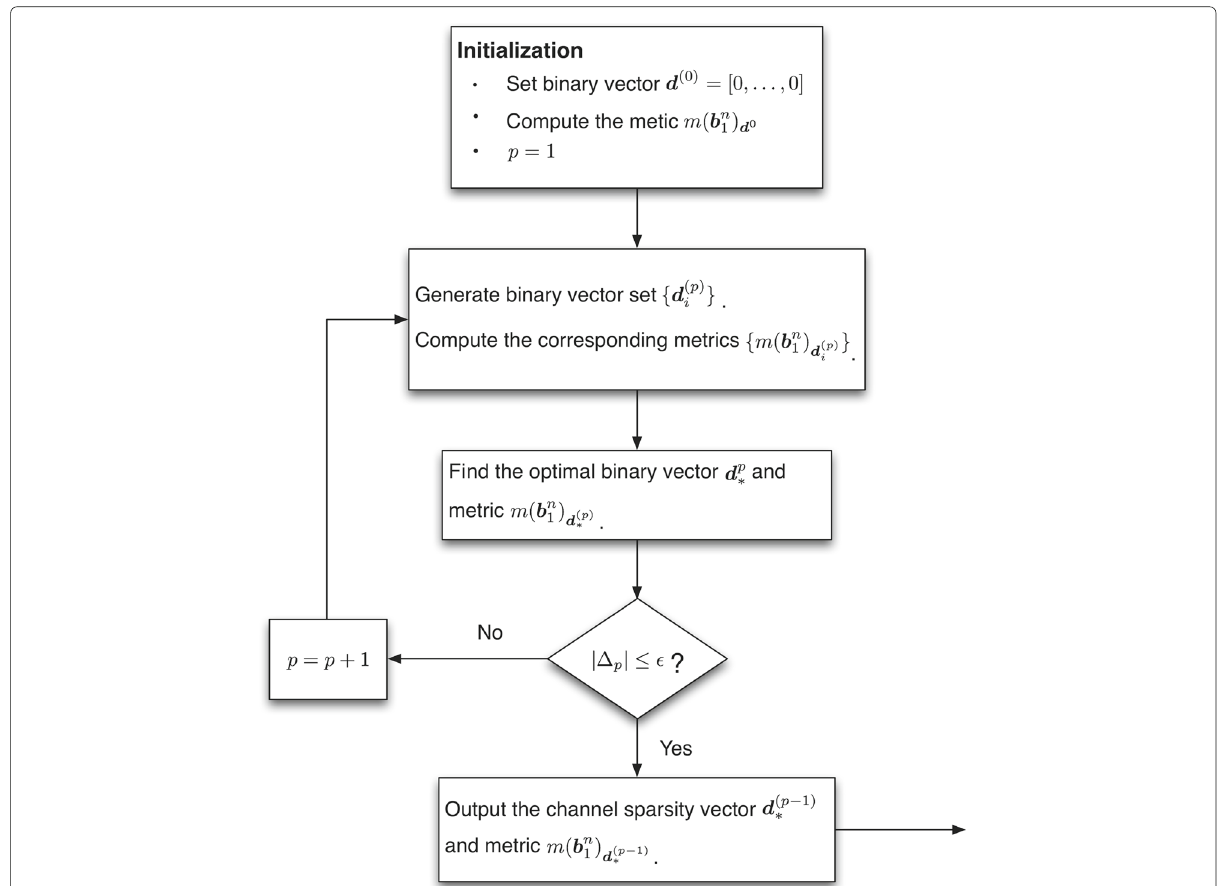
Fig. 3 A flow chart representation of the MA-based technique for updating the path metric